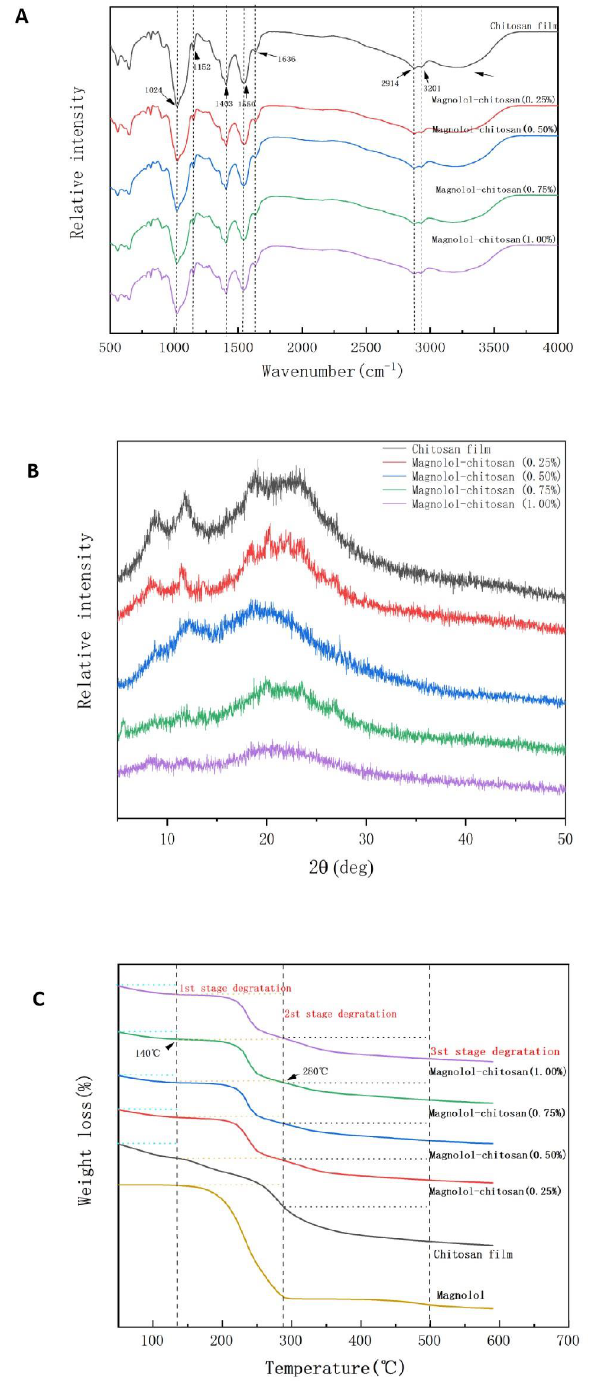
Figure 3. FTIR spectra ( A ), XRD patterns ( B ) and TGA ( C ) analysis of chitosan films without and with different contents of magnolol.